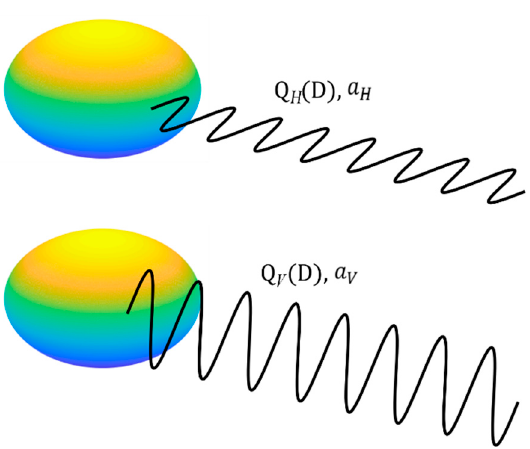
Figure 1. An oblate raindrop has different extinction cross sections and causes different attenuations for vertically and horizontally polarized signals.